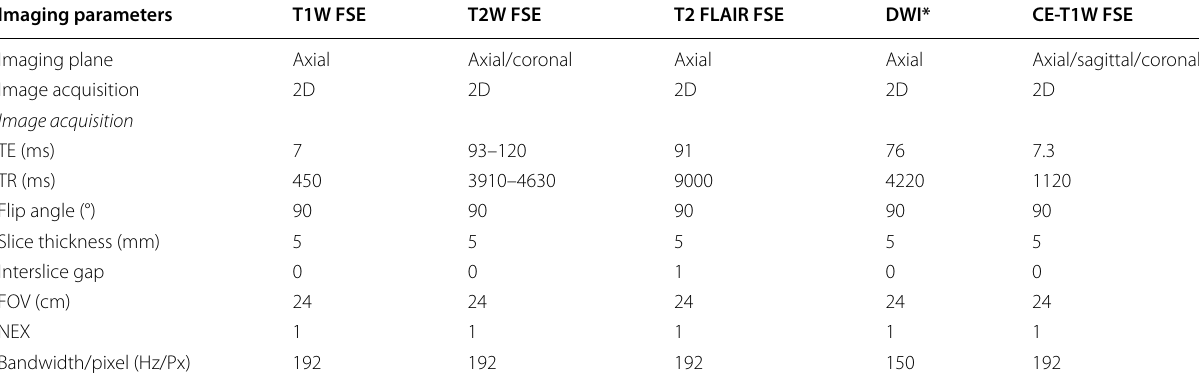
Table 1 Parameters of acquired MRI sequences in post-treated glioma imaging